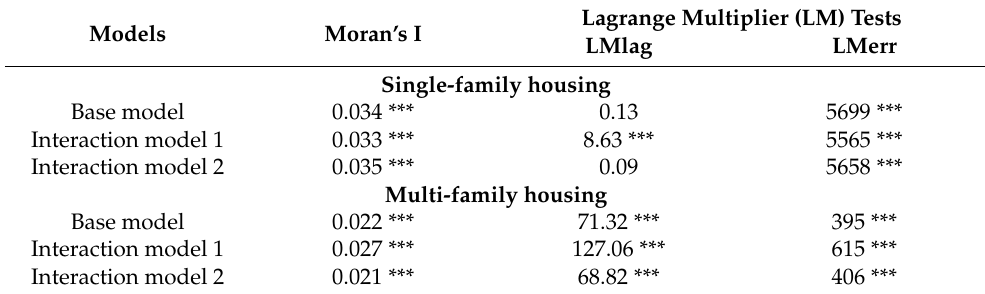
Table 3. Results of spatial dependency tests.